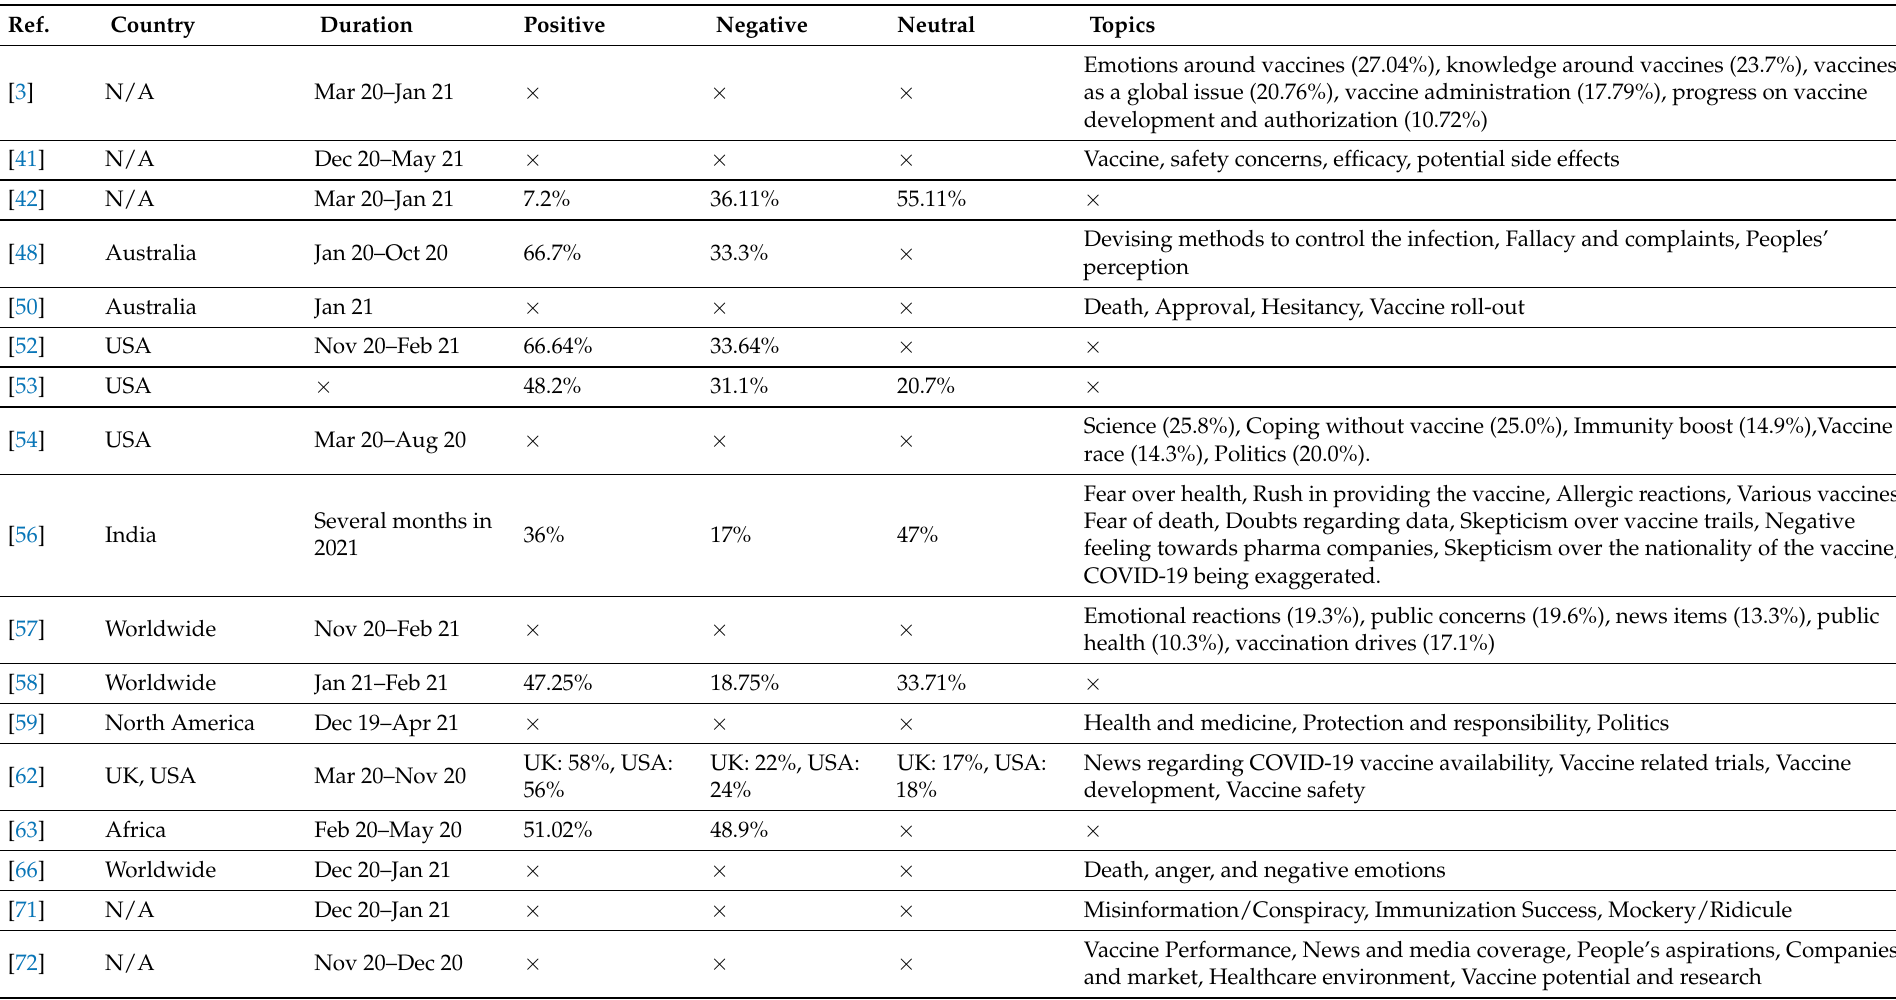
Table 6. Public perception of COVID-19 vaccines according to reviewed